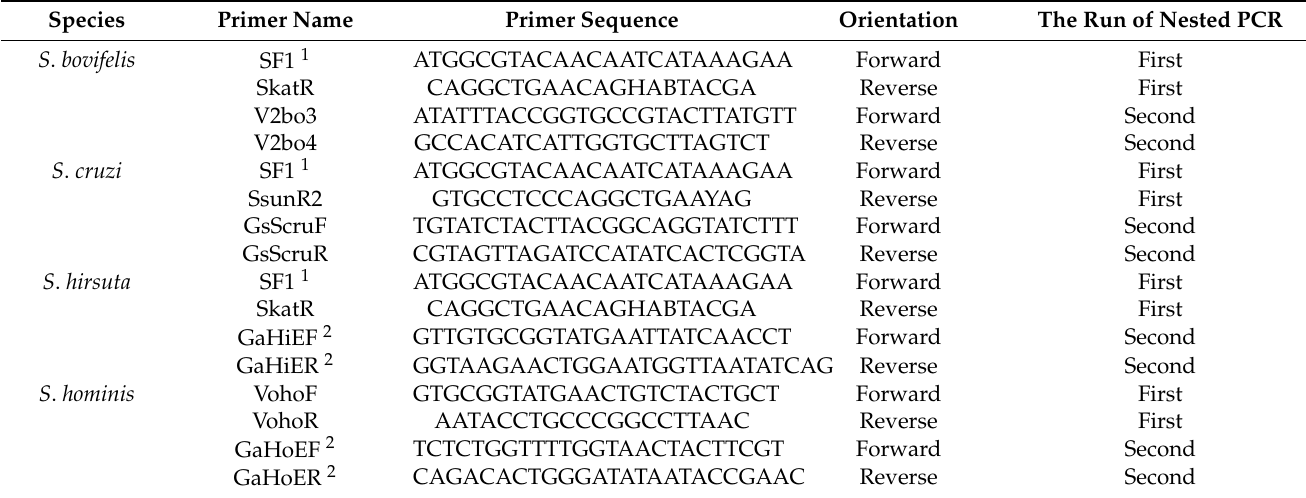
Table 1. The primers used for the nested